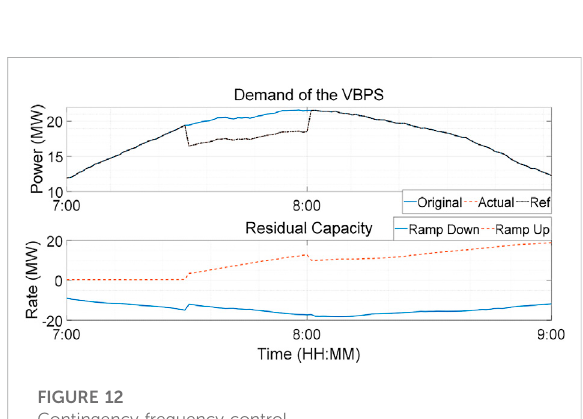
FIGURE 9 Charge/discharge rate of the VBPS.